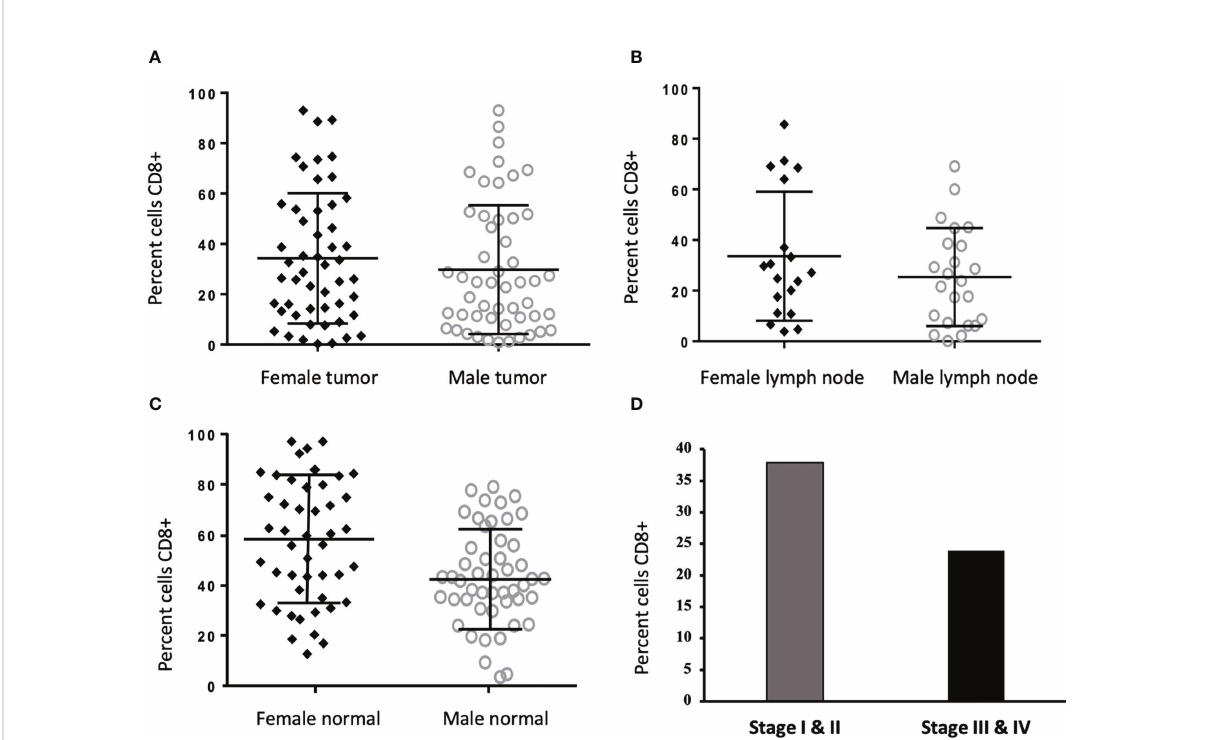
FIGURE 3 CD8+ cells are increased in normal colon tissue of women and in Stage I/II tumors. (A-C) Frequency of CD8+ staining reported as percent cells positive in tumor (34.77% vs. 29.81%, p=0.145) and lymph node (34.41% vs. 25.39%, p=0.591) were not different between men (n = 50) and women (n = 51), however, CD8+ was increased in normal tissue from women as compared to men (47.40% vs. 34.61%, p=0.015). (D) When strati fi ed into cancer stages, CD8+ cells more frequently in fi ltrated tumors from stages I and II (n = 47) compared to III and IV (n = 54)(37.01% vs 23.91%